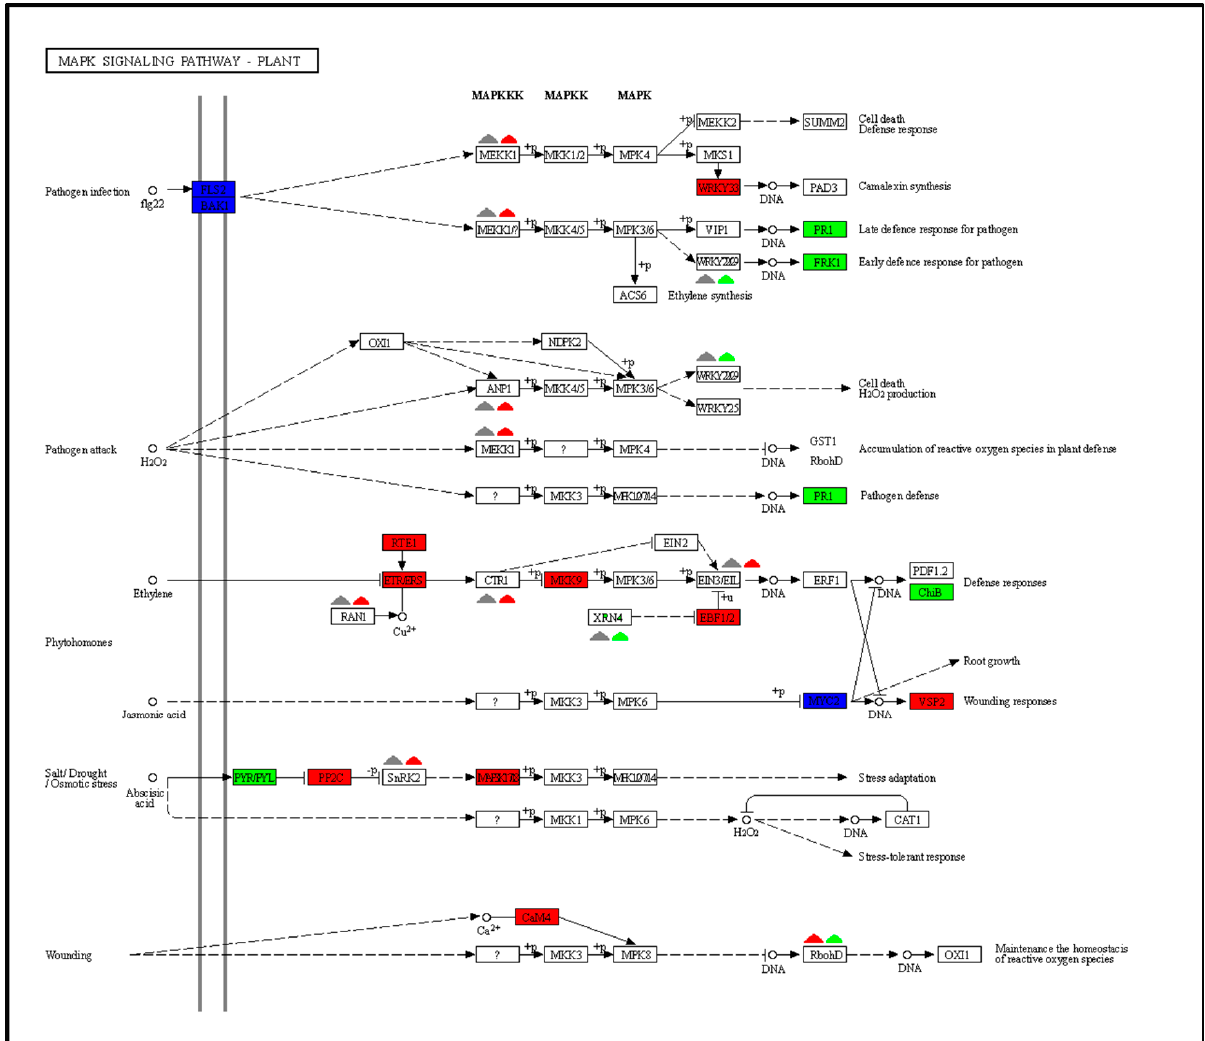
Figure 7. Differentially expressed genes are involved in MAPK signaling pathway. Expression values of the DEGs are presented as log 2 Fold Change > 1 (red for upregulated, green for downregulated, blue for both upregulated and downregulated, and gray for no significant changes). The rectangle represents common change trend, and the triangle represents different change trend. The first and second triangles represent plants with epicuticular wax and without epicuticular wax, respectively.